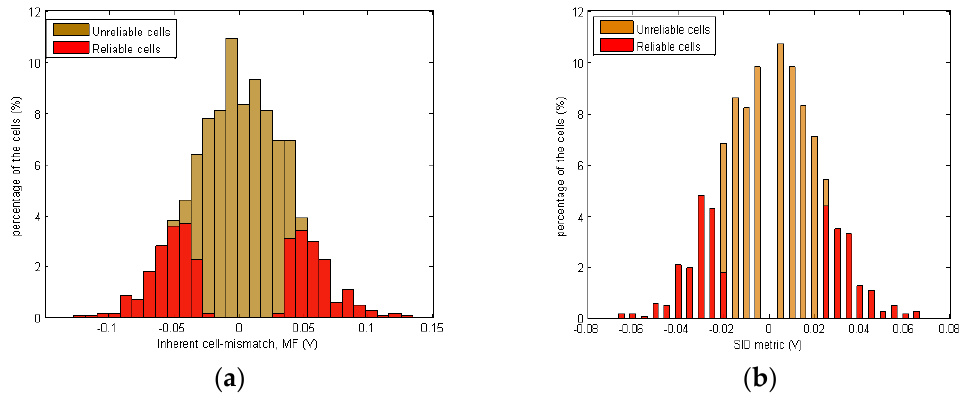
Figure 14. The histograms for the proposed metrics indicate a consistent distribution: ( a ) for MF metric, ( b ) for SID metric.